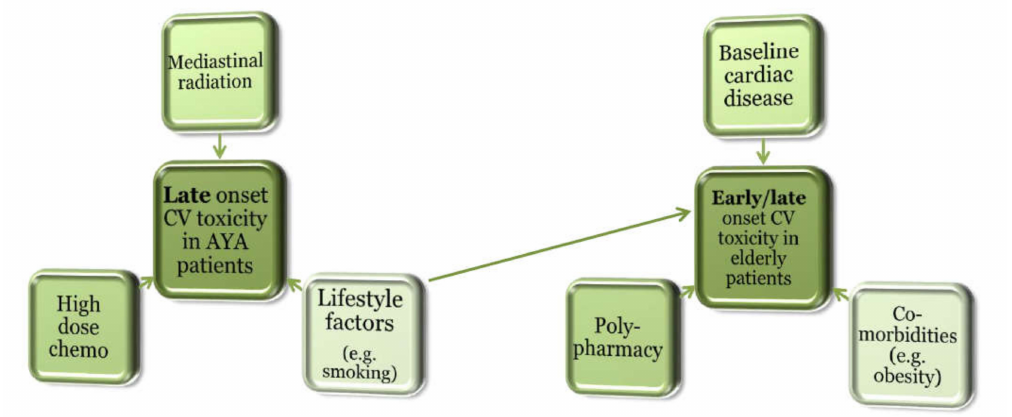
Figure 2. Common contributors to cardiovascular disease after cancer at extremes of